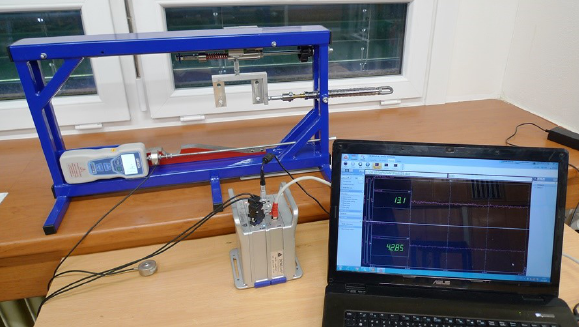
Figure 5: Testing equipment for the calibration of force transducers Figure 6: Equipment for the determination of a compression